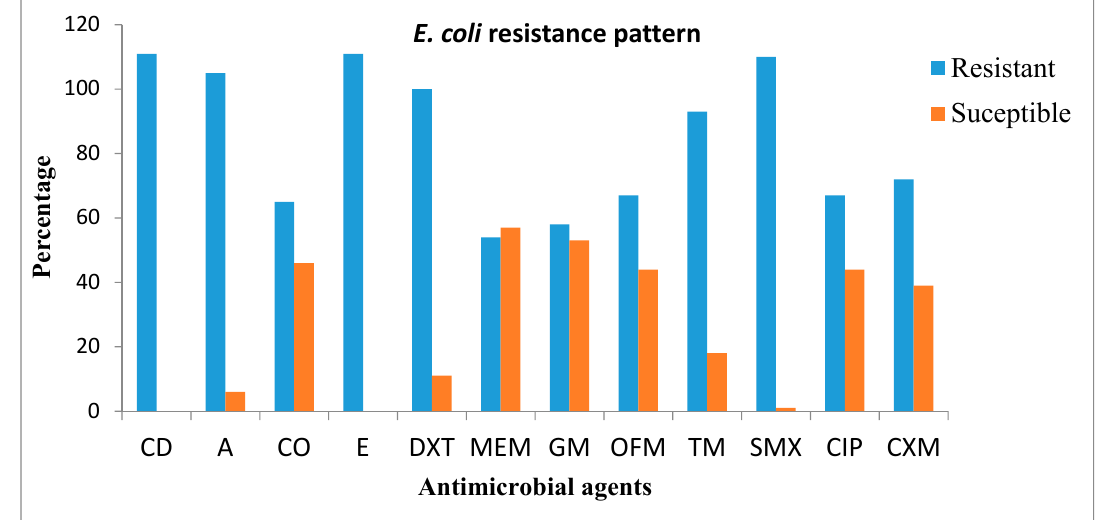
Figure 2. Antimicrobial susceptibility patterns of E. coli isolated from wastewater treatment plants (WWTPs) in the Eastern Cape South Africa. Clindamycin (CD), Amoxicillin (A), Colistin-sulphate (CO), Erythromycin (E), Doxycyline (DXT), Cefuroxime (CXM), Meropenem (MEM), Gentamicin (GM), Ofloxacin (OFX), Trimethgoprim (TM), Sulphamethaxole (SMX), and Ciprofloxacin (CIP).